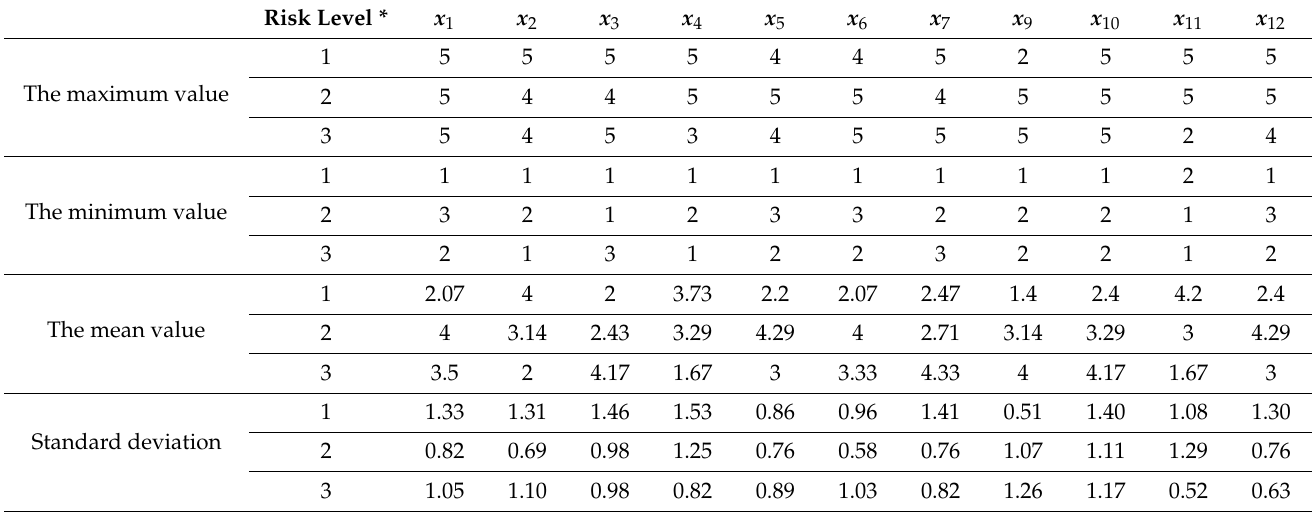
Table 2. Descriptive statistics for the evaluation indicators of the 28 large-scale sports